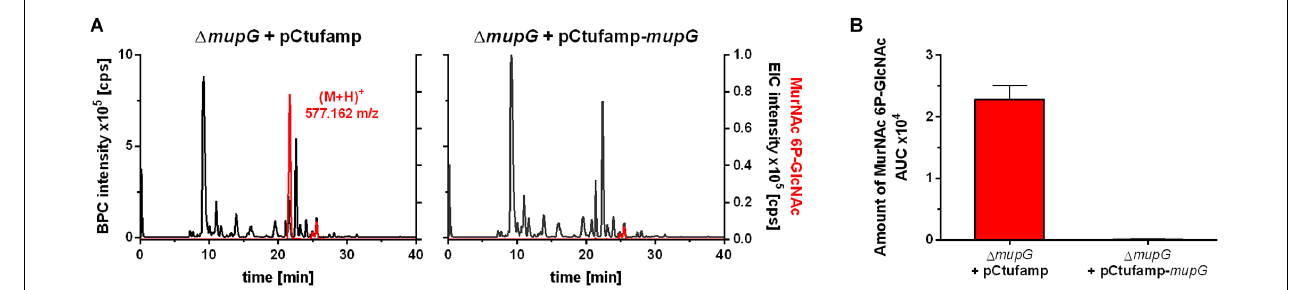
FIGURE 5 | LC-MS analysis of cell extract from MupG complemented mutant. S. aureus (cid:49) mupG cells transformed with the control pCtufamp plasmid ( (cid:49) mupG + pCtufamp) or with the mupG complementation plasmid pCtufamp- mupG ( (cid:49) mupG + pCtufamp- mupG ) were grown for 24 h. Cytosolic fractions were analyzed by LC-MS in positive ion-mode. (A) Mass spectra of the samples were presented as base peak chromatograms (BPC × 10 5 counts per s [cps]) in black and as extracted ion chromatograms (EIC × 10 5 [cps]) for MurNAc 6P-GlcNAc with observed mass of (M+H) + = 577.162 m/z in red. (B) MupG complementation experiment was performed in triplicates and the relative amount of the MurNAc 6P-GlcNAc in the cells was determined by calculating the area under the curve (AUC) of the respective EIC spectra.